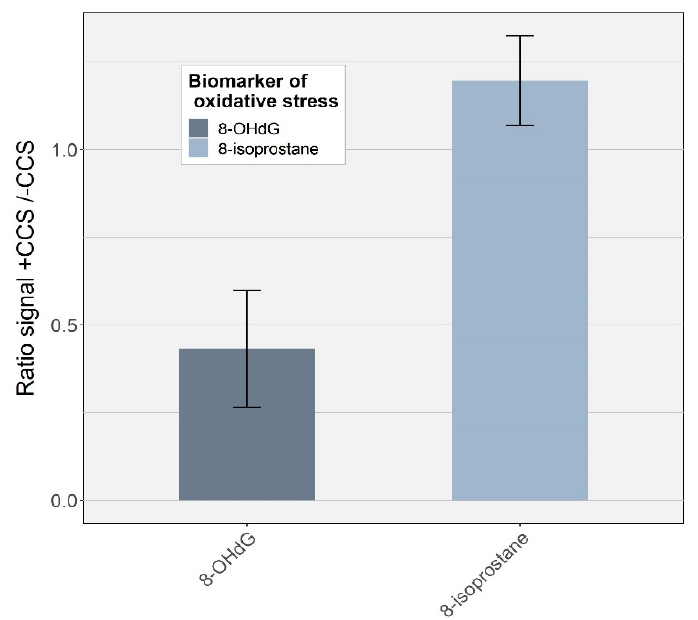
Figure 3. Effect of using the centrifugal concentrator system on the signal of both analytes in EBC. Bars correspond to standard deviation of three independent repetitions. CCS = centrifugal concentrator system.